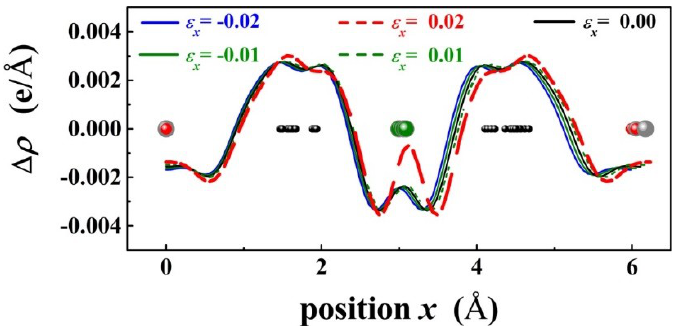
Figure 7. The plane averaged electron density difference ∆ ρ of PbPd 0.75 Co 0.25 O 2 under ε x = − 0.02, − 0.01, 0.00, 0.01, 0.02, where the projection of ∆ ρ was along the x axis.